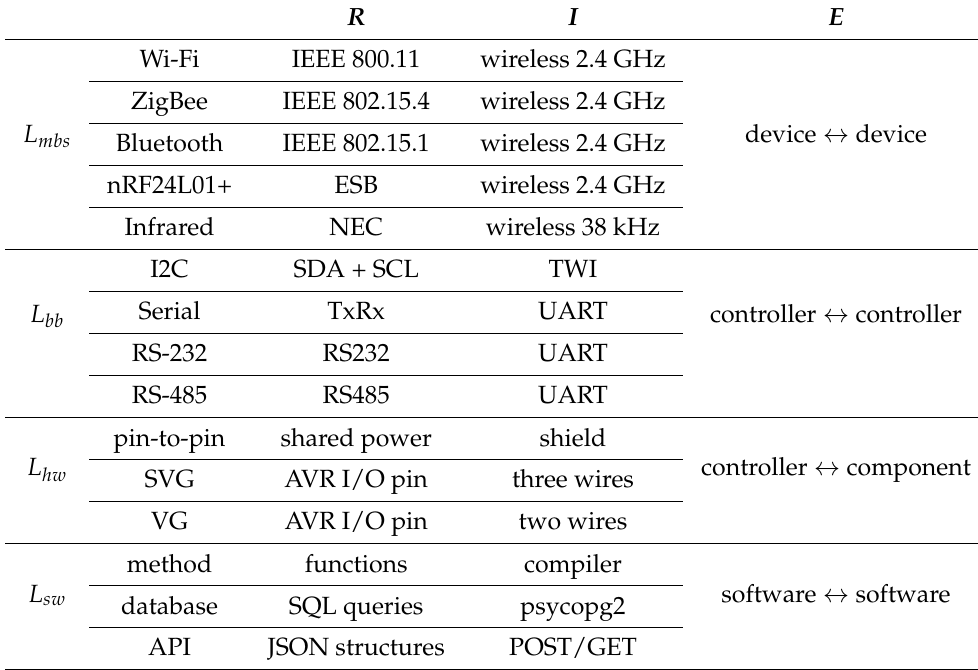
Table 1. Various types of links between